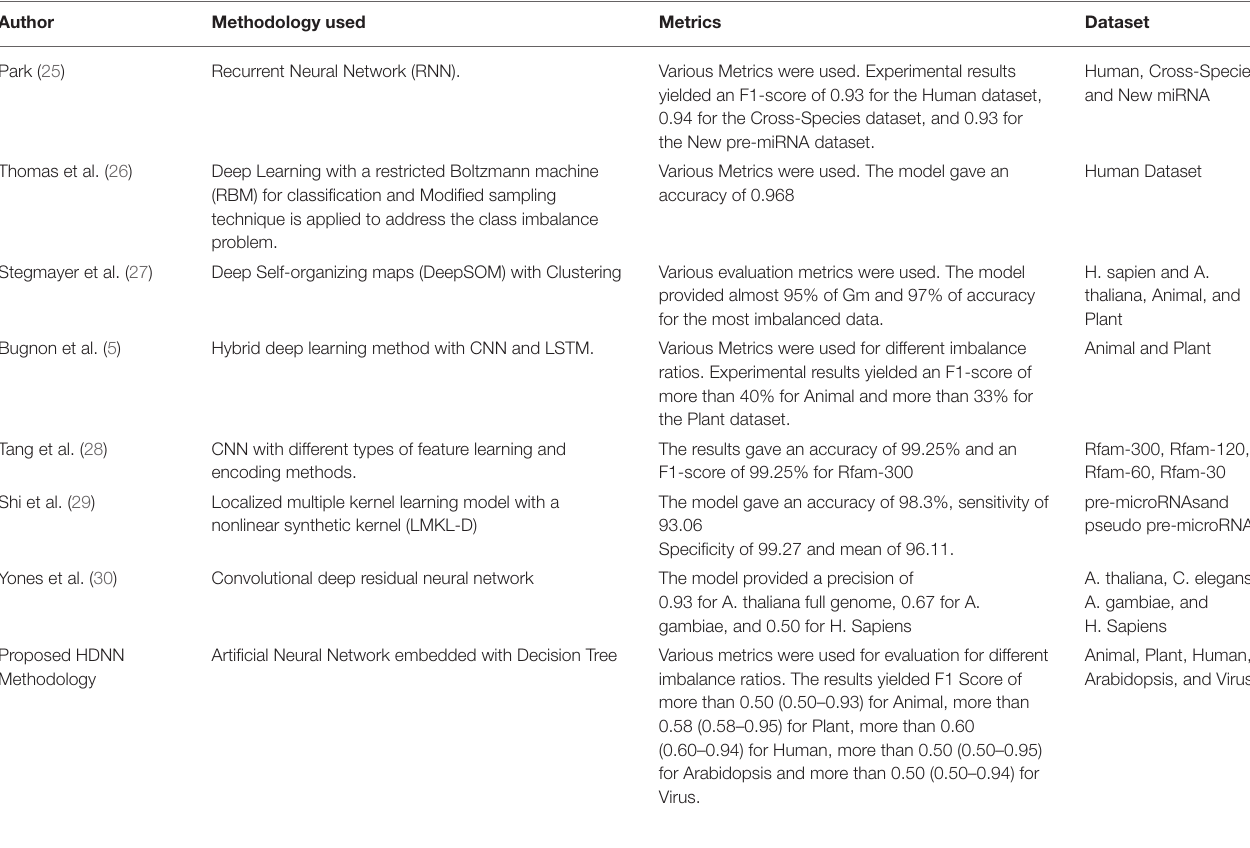
TABLE 1 | Comparison of various state-of-the-art